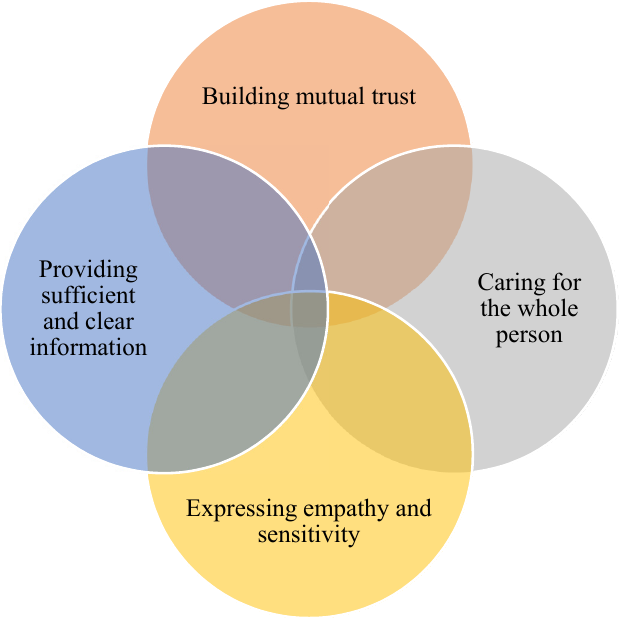
Figure 1. Important aspects to include in person-centred models to support respect and humanity during clinical encounters .